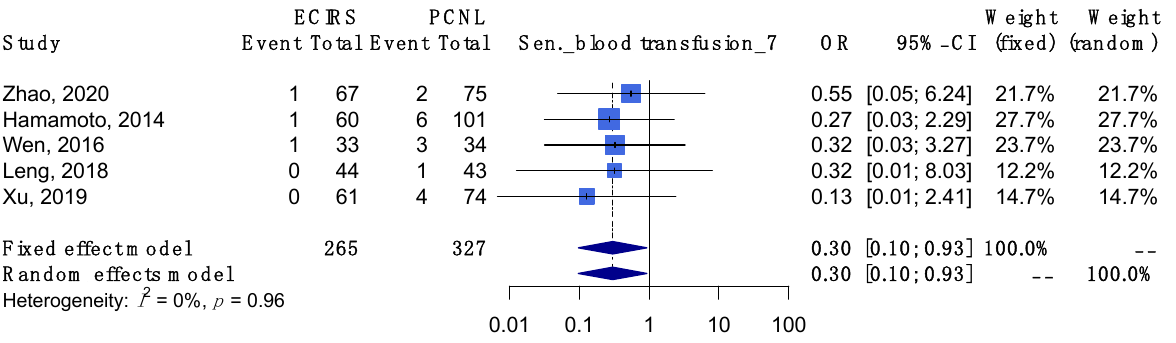
Figure A24. Sensitivity analysis of outcome regarding hemoglobin drop. ([18,19,22,23]).